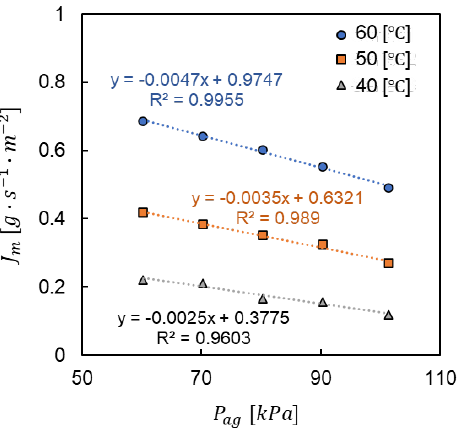
Figure 10. Produced water flux according to the air-gap pressure and feed and coolant water temperatures.